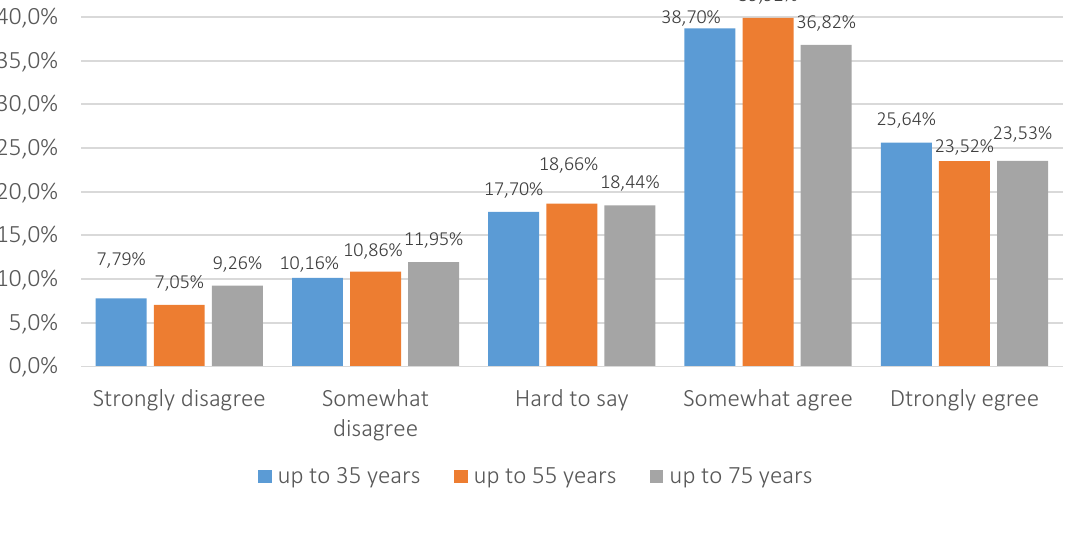
Figure 3. The quality of interpersonal relationships at work vs. a respondent’s